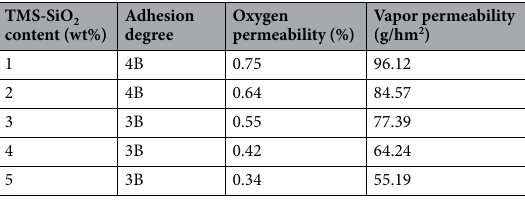
Table 1. The physical properties of PSC/TMS-SiO 2 film as a function of TMS-SiO 2